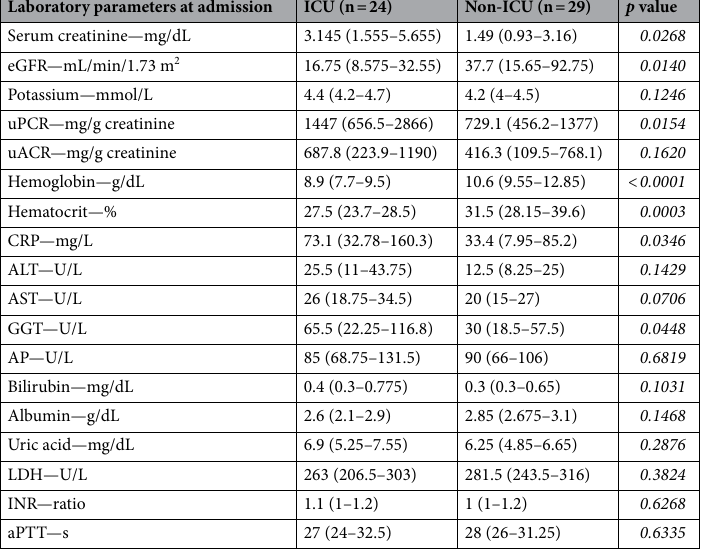
Table 3. Parameters at admission in ICU and non-ICU patients with ANCA-associated renal vasculitis. Continuous variables are expressed as median and IQR, the Mann–Whitney U test was used for group comparisons to determine differences in medians.